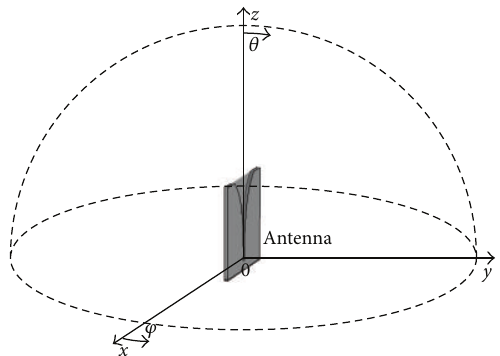
Figure 2: Vivaldi antenna (the reference frame is indicated in the figure).